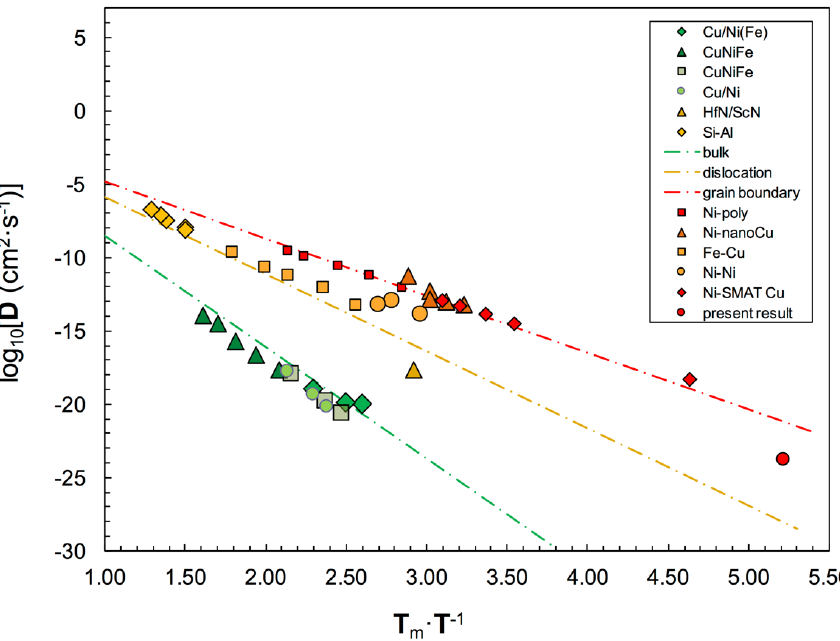
Figure 6. The Arrhenius plot of experimental diffusivity Ď (cm 2 ·s −1 ) data with the ratio of melt point T m to test temperature T for the Cu-Ni(Fe), Ni-Cu, Fe-Cu, Ni-Ni, Si-Al, and HfN-ScN systems is shown along with generic diffusivity curves [32] for identifying the bulk-, dislocation-, and grain boundary-based diffusion mechanisms (